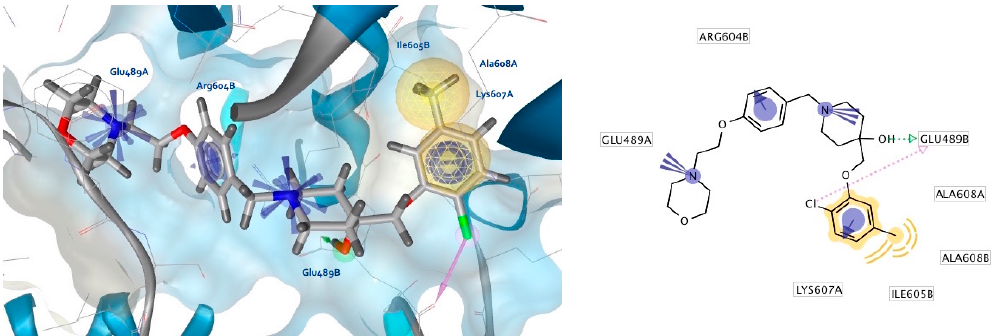
Figure 12. Interactions of compound 11 with the Hsp90 CTD binding site from the MD simulation used to derive the SB-model for virtual screening. The pharmacophore features are as follows: hydrophobics (yellow spheres), aromatics (blue discs), hydrogen bond donor (green arrow), positive ionizables (blue stars), halogen bond (pink arrow).